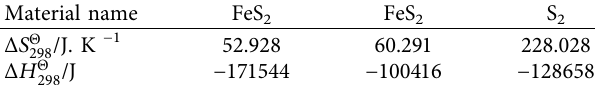
Table 1: Thermodynamic